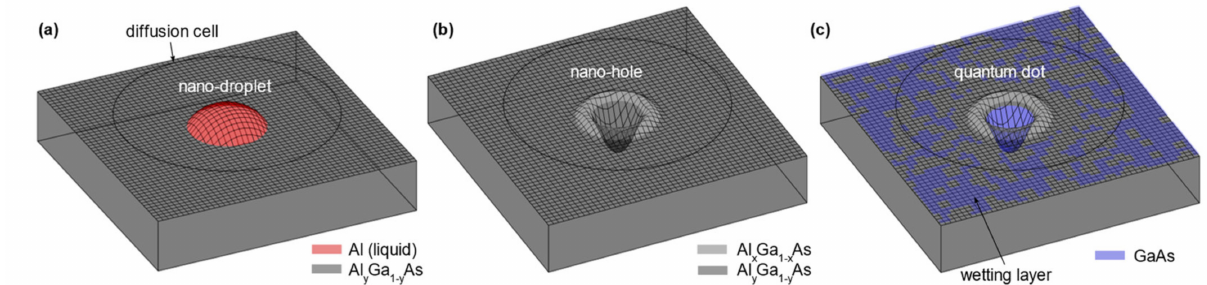
Figure 1. Schematic illustration of QD fabrication by LDE and hole filling. ( a ) Aluminum droplets form due to sufficiently low As-flux and etch into the surface. ( b ) A nano-hole is left behind after the etching process is terminated, and etched material agglomerates in a wall surrounding the hole. In the case of aluminum used for etching, the wall has a higher Al concentration then the matrix material [28]. ( c ) GaAs is deposited and fills the nanohole. Nearby material diffuses into the hole, and the diffusion area (Voronoi-cell) correlates with the filling level [29]. In between the nanoholes, GaAs forms a quantum well, which is called a wetting layer, in accordance with the term used for InGaAs